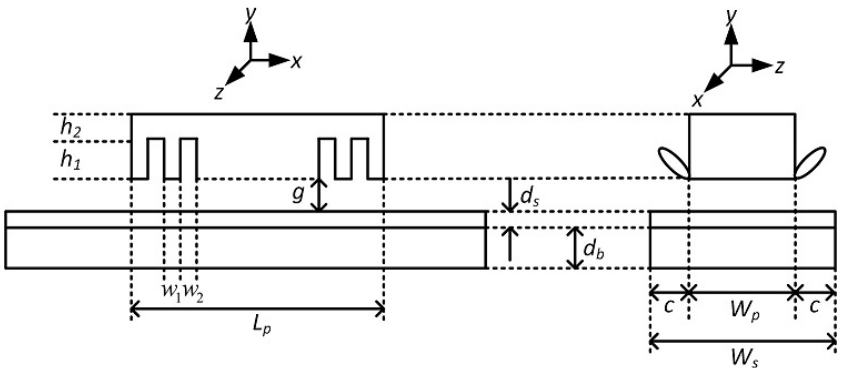
Figure 3. The dimensional structure of a linear induction motor